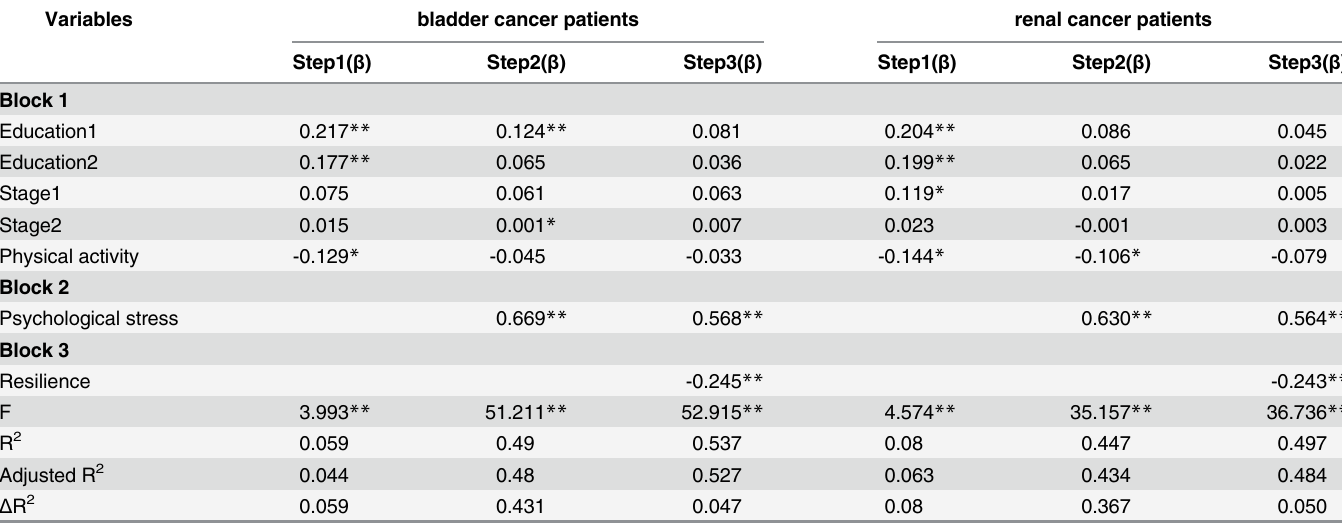
Table 3. Hierarchical linear regression analyses results of depressive